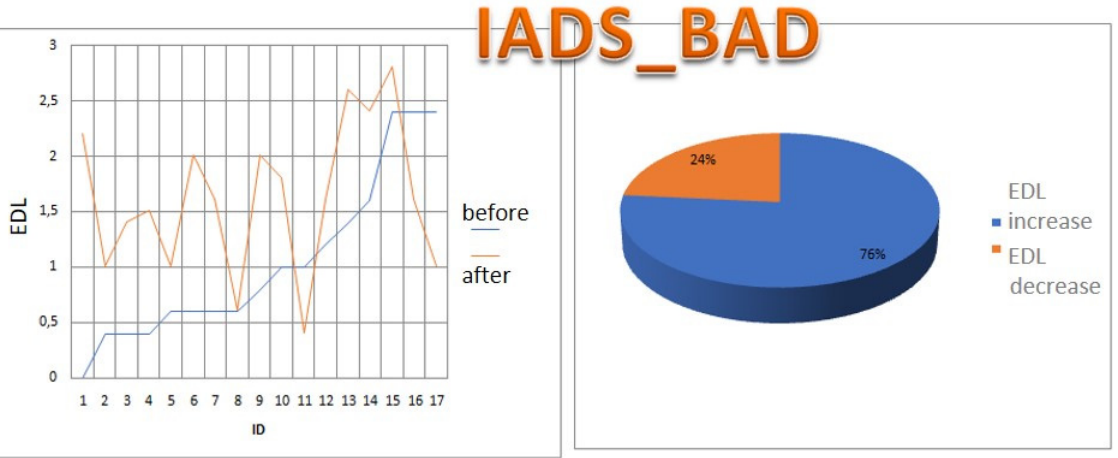
Figure 14. The mean values of the emotional disadaptation level (EDL Test) before and after negative stimulation.